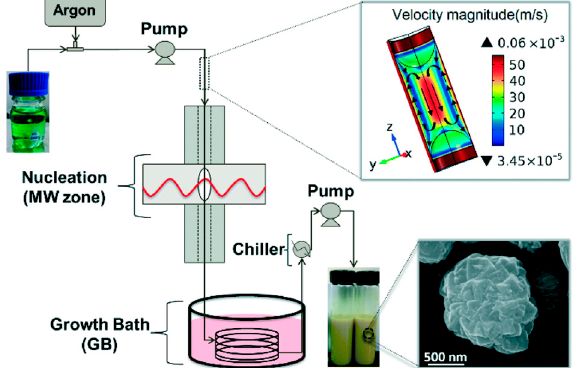
Figure 4. The schematic representation of the CFMR for the synthesis of MOF-74 (Ni). Reproduced with permission from [91].